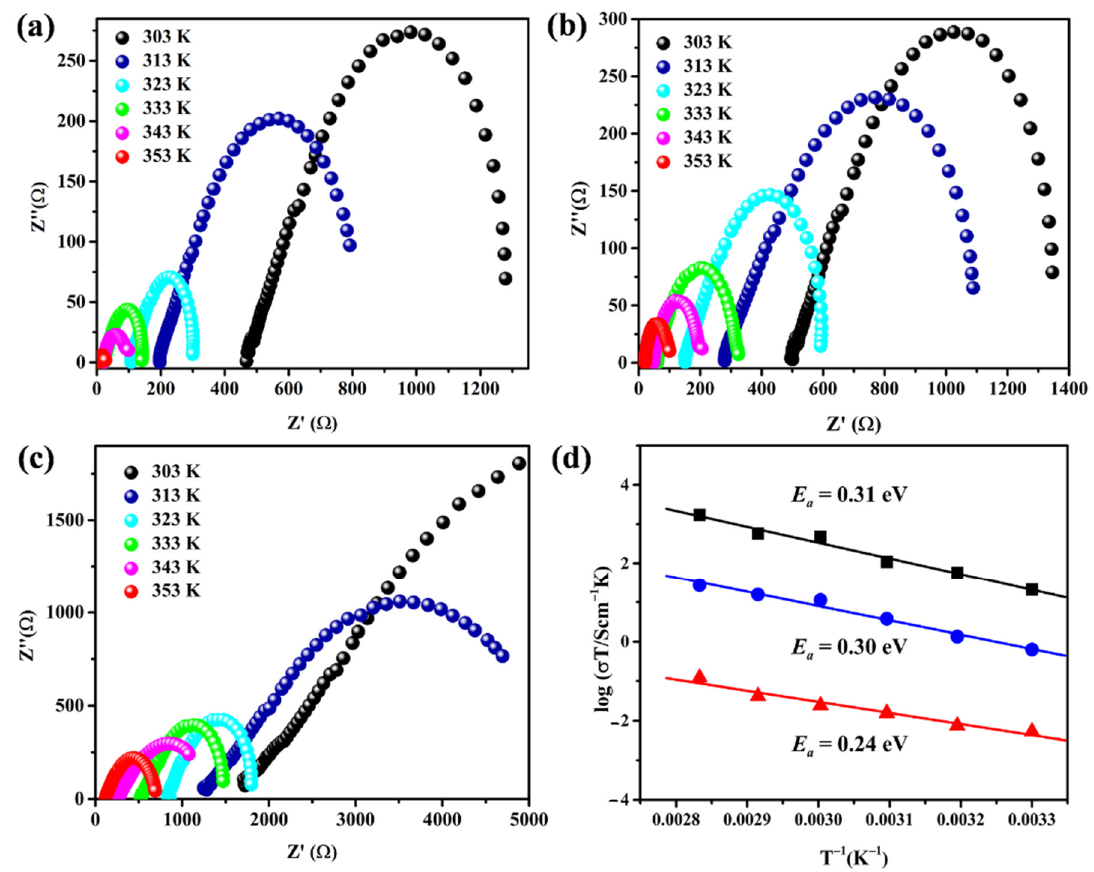
Figure 4. Nyquist plots of PA-PhSO 3 H measured at different temperatures and different relative humidity: ( a ) 98% RH, ( b ) 85% RH, ( c ) 75% RH. ( d ) Arrhenius plots of proton conductivity for PA-PhSO 3 H at 98% RH (black), 85% RH (blue), and 75% RH (red).